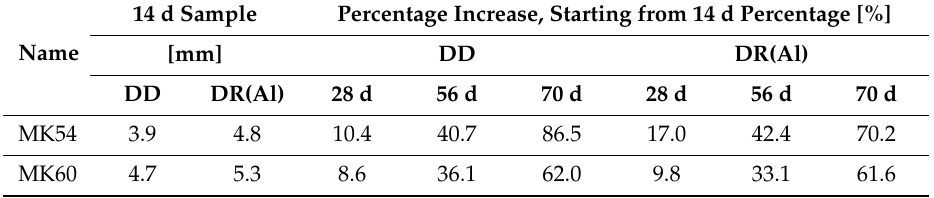
Table 4. DD and DR(Al) of 14 d sulfuric acid exposed geopolymer samples and the percentage increase of DD and DR(Al) starting from the 14 d exposed sample for exposed samples 28 d, 56 d, and 70